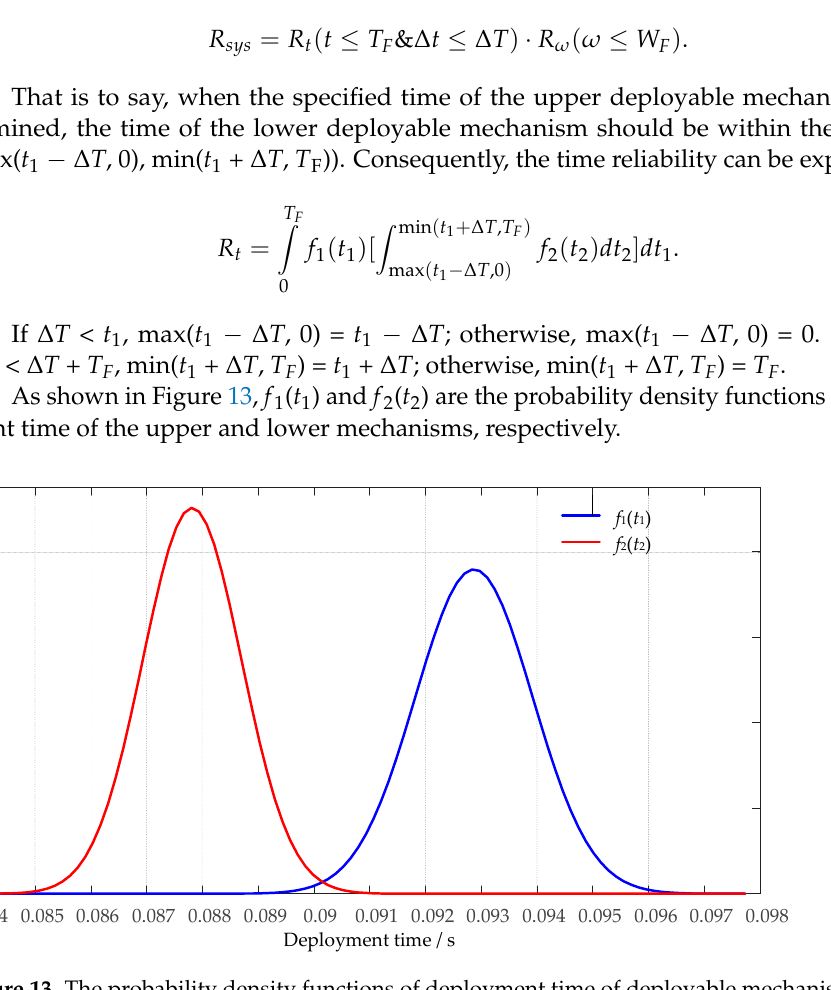
Figure 13. The probability density functions of deployment time of deployable mechanisms. Table 4. Comparison of time reliability.